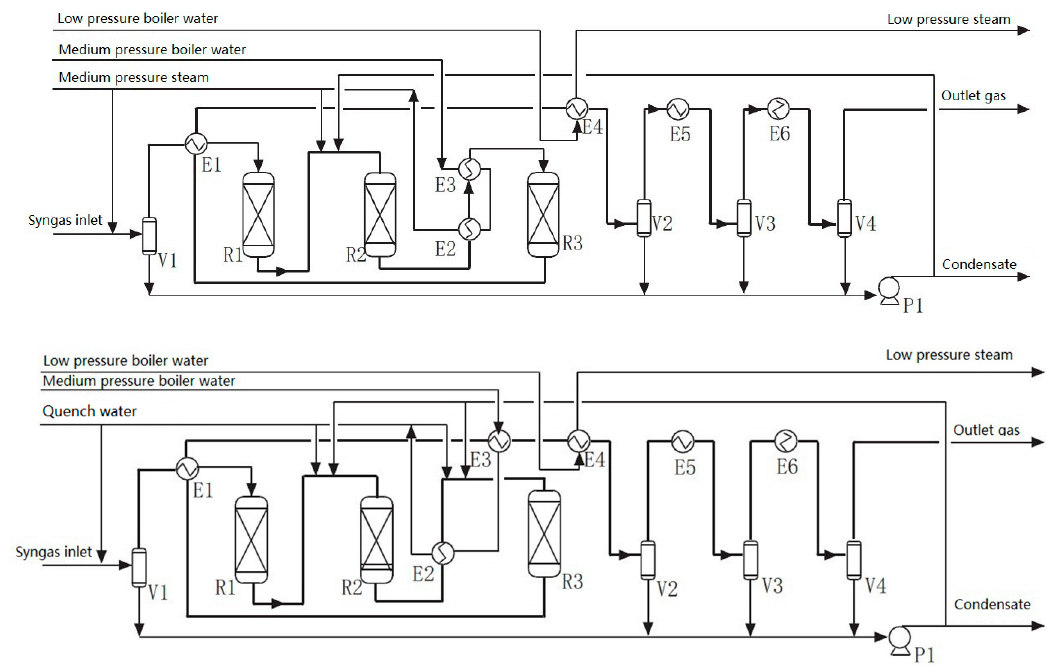
Figure 1. High (1.6 or higher) steam / gas ratio WGS ( top ) vs. Low steam / gas ratio WGS ( bottom ). E1 preheater; E2 medium pressure waste heat boiler; E3 preheater of medium pressure